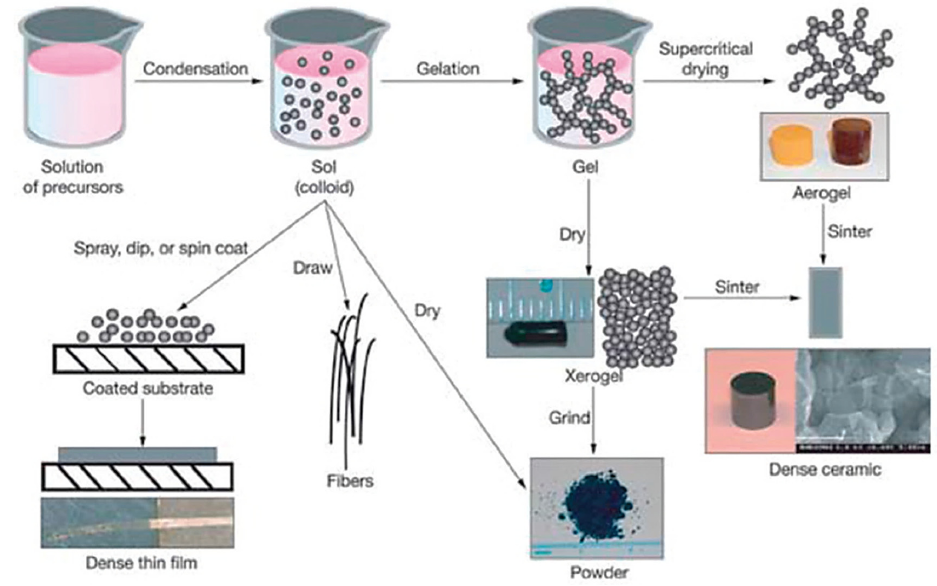
Figure 4. Stages of the sol-gel process [56].